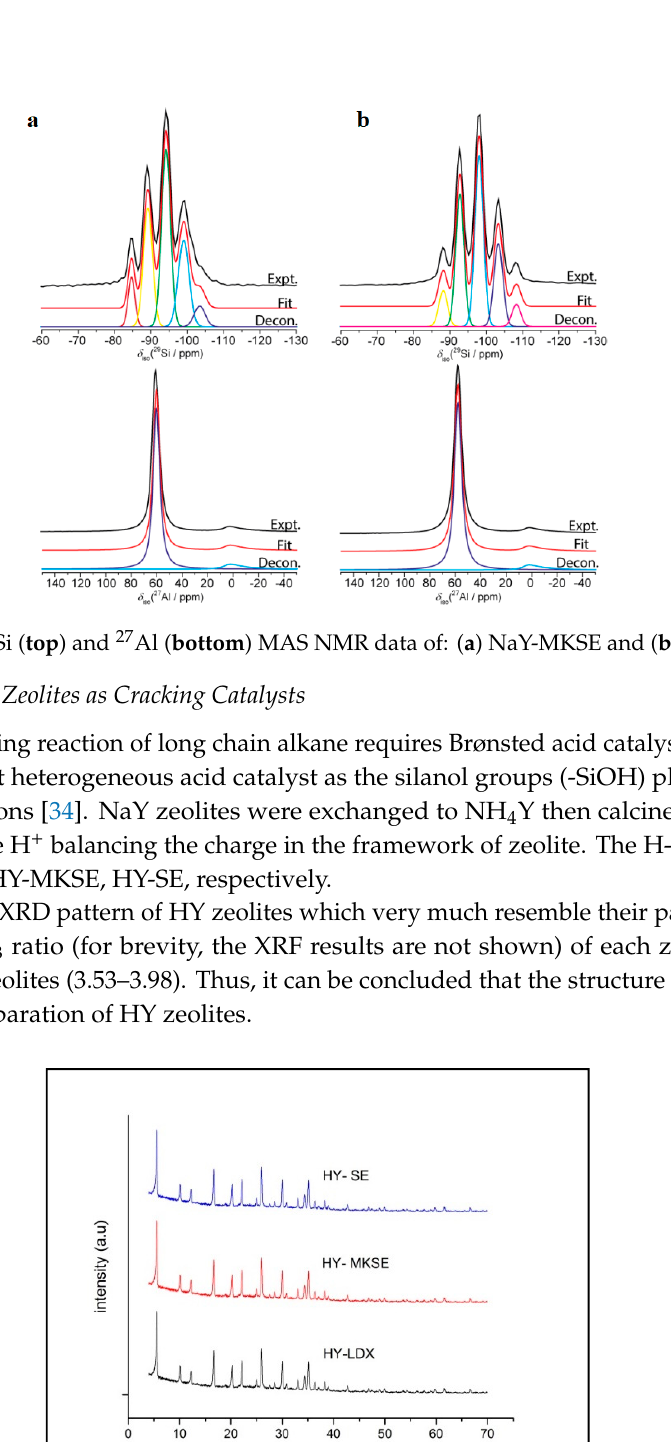
Figure 12. 29 Si ( top ) and 27 Al ( bottom ) MAS NMR data of: ( a ) NaY-MKSE and ( b ) NaY-SE.